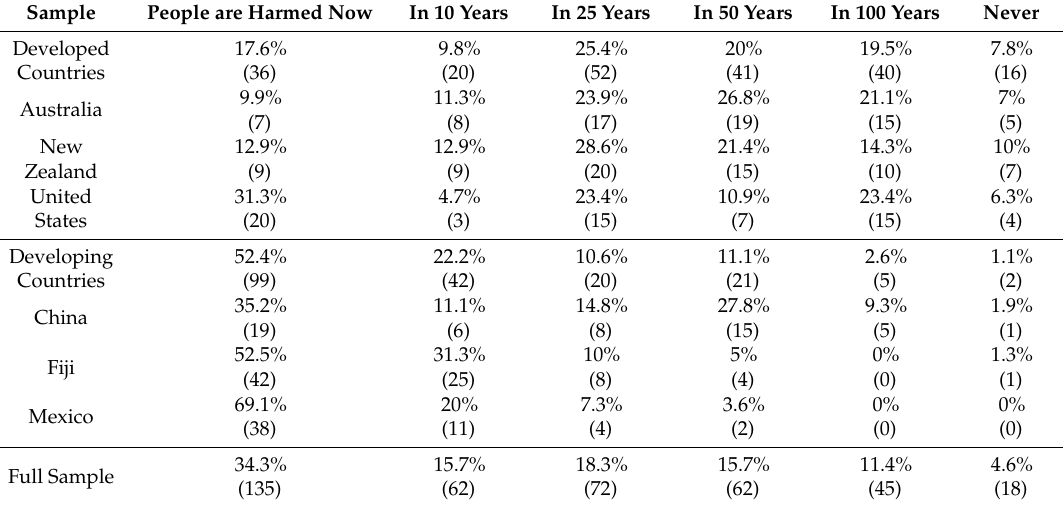
Table 7. Frequency on item: when do you think climate change will start to substantially harm people in your country?